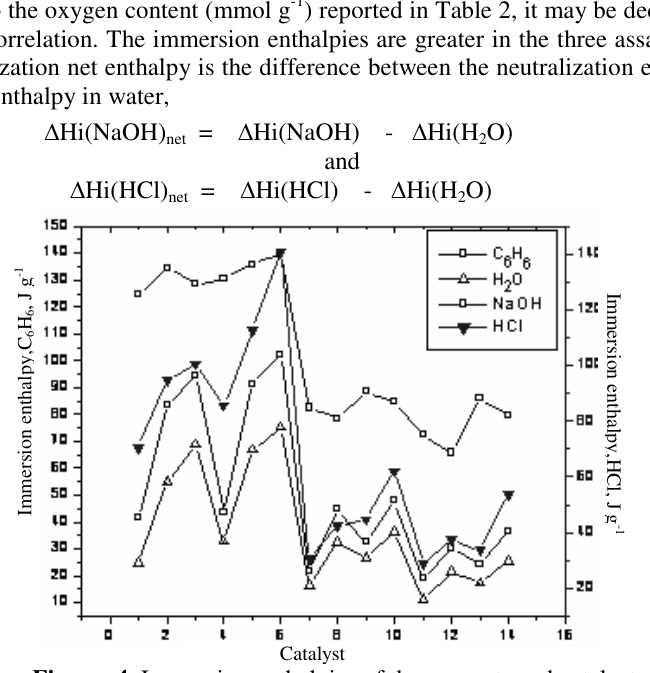
Figure 4. Immersion enthalpies of the supports and